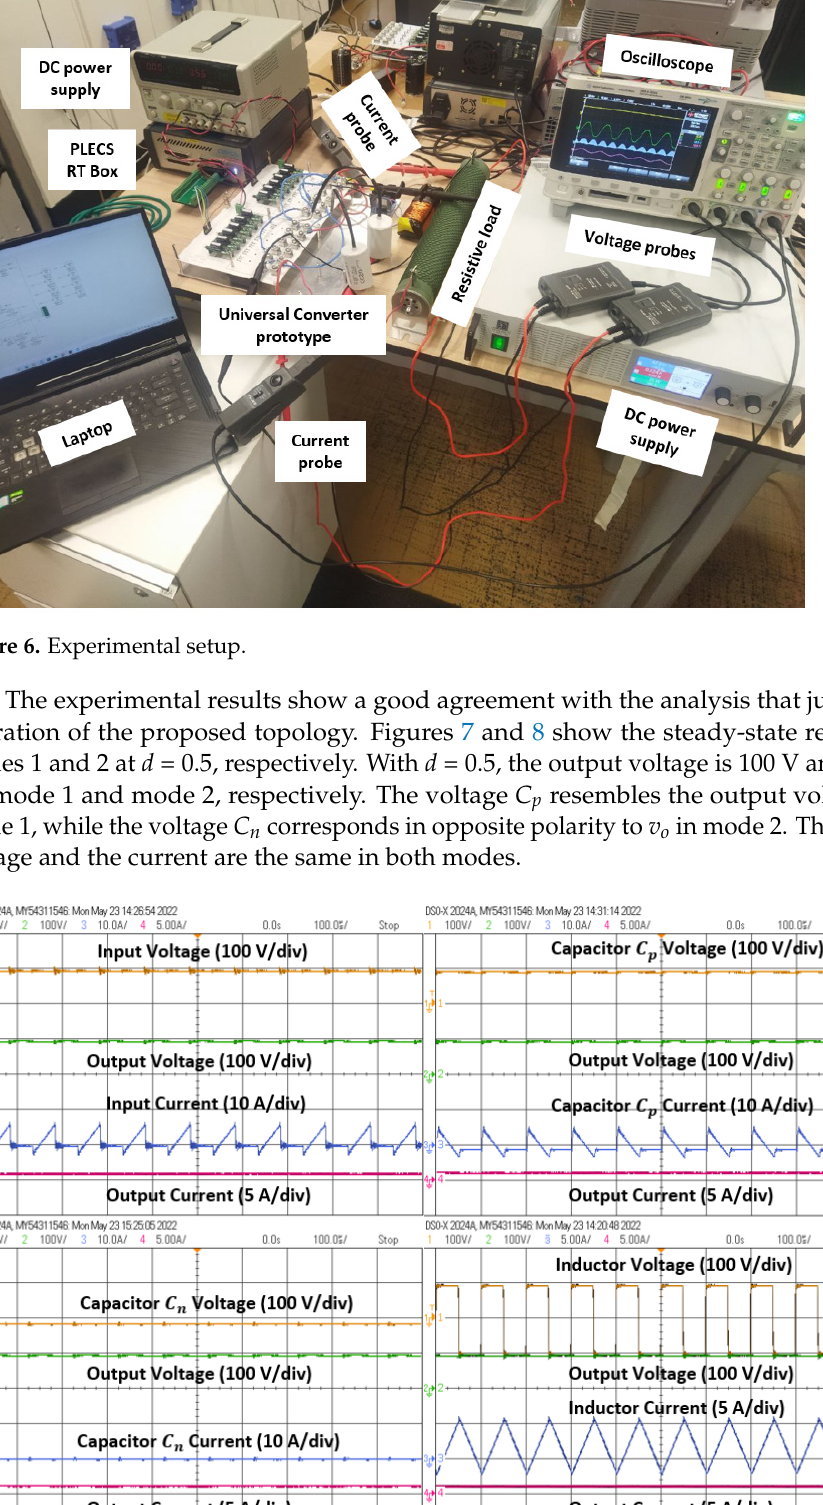
Figure 7. Steady-state response of mode 1 at d = 0.5.